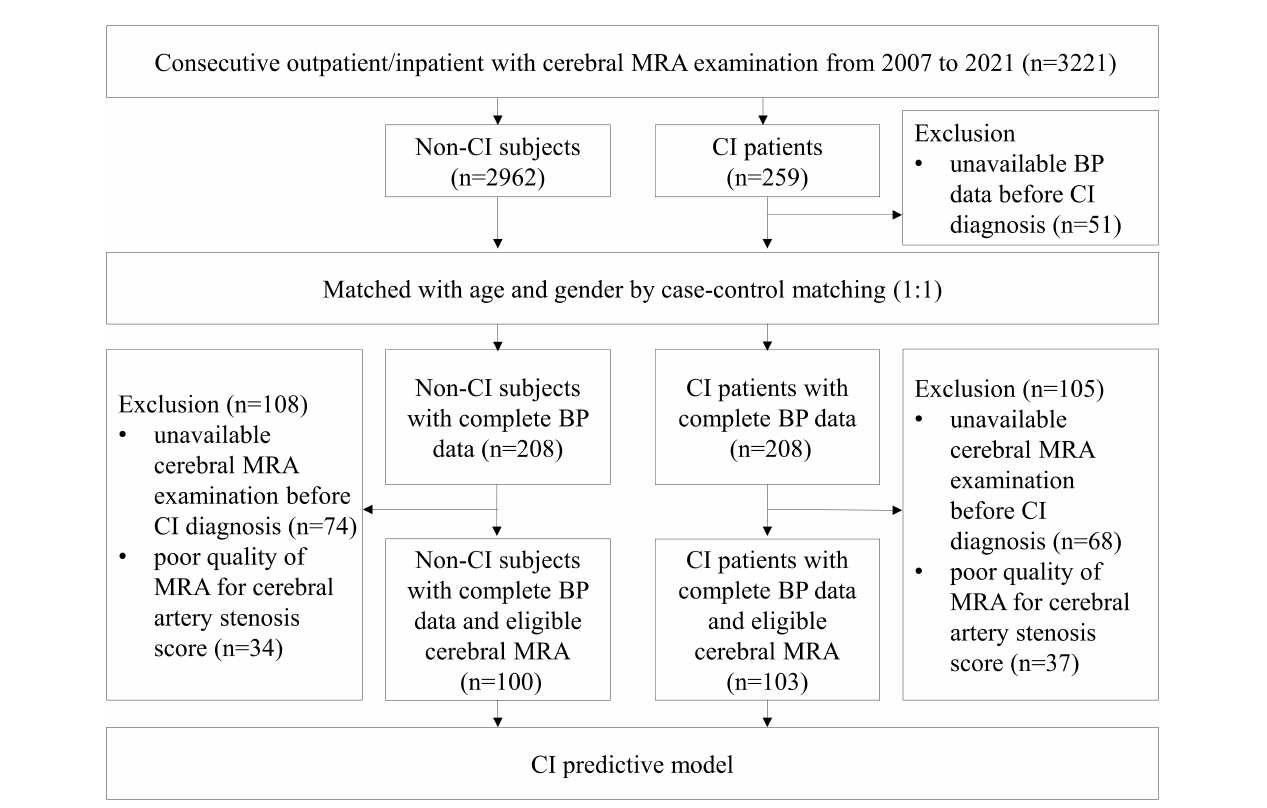
FIGURE1 Flow chart of sample selection. Among 3,221 consecutive outpatient and inpatient who underwent cerebral MRA examinations, 208 CI patients and 208 age- and sex-matched non-CI subjects with complete BP data before onset of CI were applied to analyze the relationship between the means of various BP parameters and CI. In addition, 103 CI patients and 100 control subjects with eligible cerebral MRA performed before onset of CI were applied to analyze the relationship between posterior circulatory artery score and CI. BP, blood pressure; CI, cognitive impairment; MRA, magnetic resonance angiography.